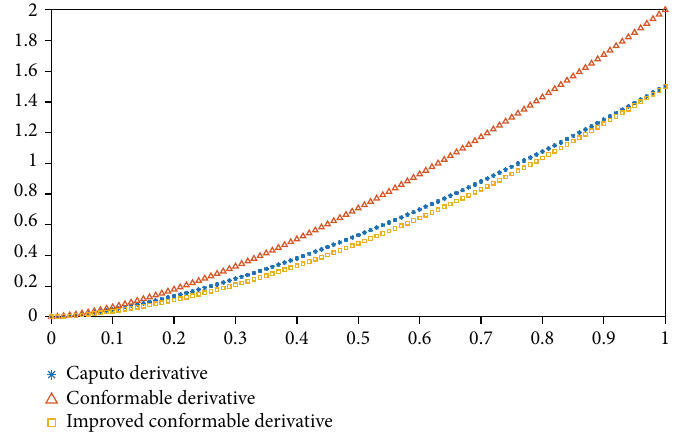
Figure 4: 0.5th fractional derivative of y = x 2 .